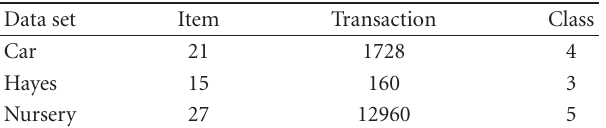
Table 11: UCI data sets.